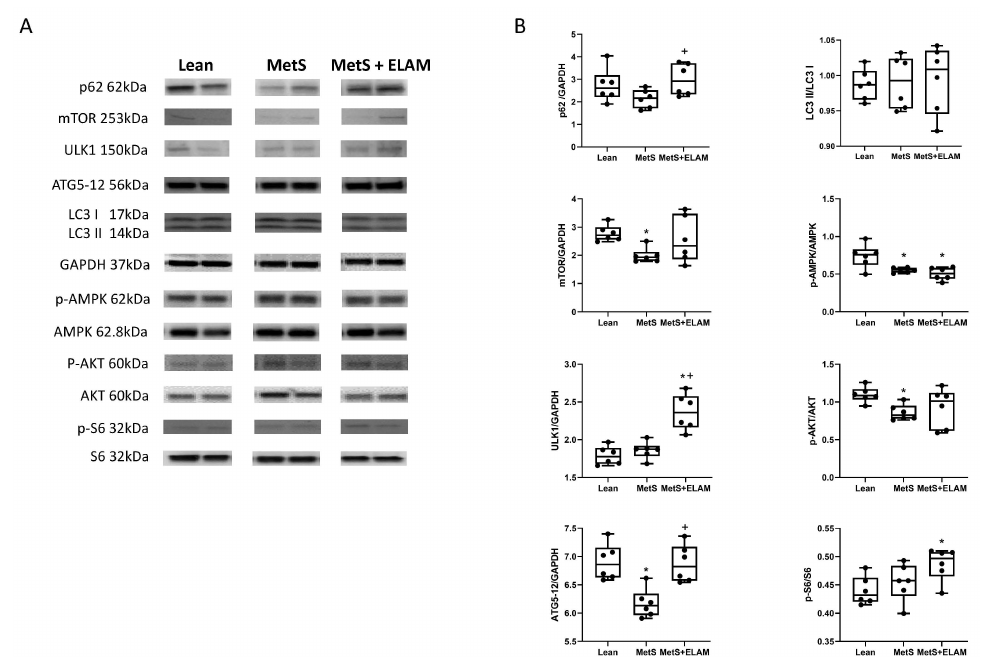
Figure 1. Renal protein expression of autophagy mediators. ( A , B ) mTOR, ATG5-12, AMPK, and P-AKT expression decreased in MetS kidneys and improved after ELAM therapy. p62 and ULK-1 also increased in MetS + ELAM kidneys. * p < 0.05 vs. lean, + p < 0.05 vs. MetS.